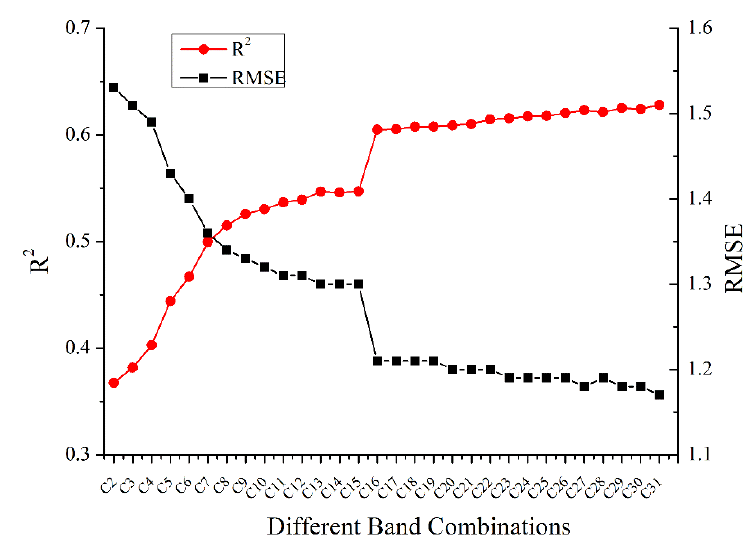
Figure 5. LAI estimation of the different number of combined bands.